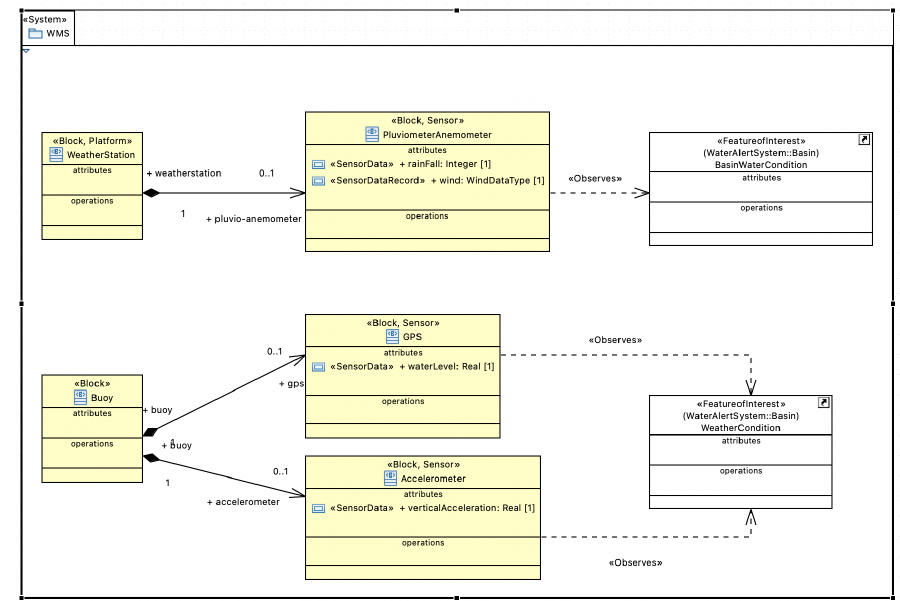
Figure 13. WAS Package: structure of the Water Monitoring System.